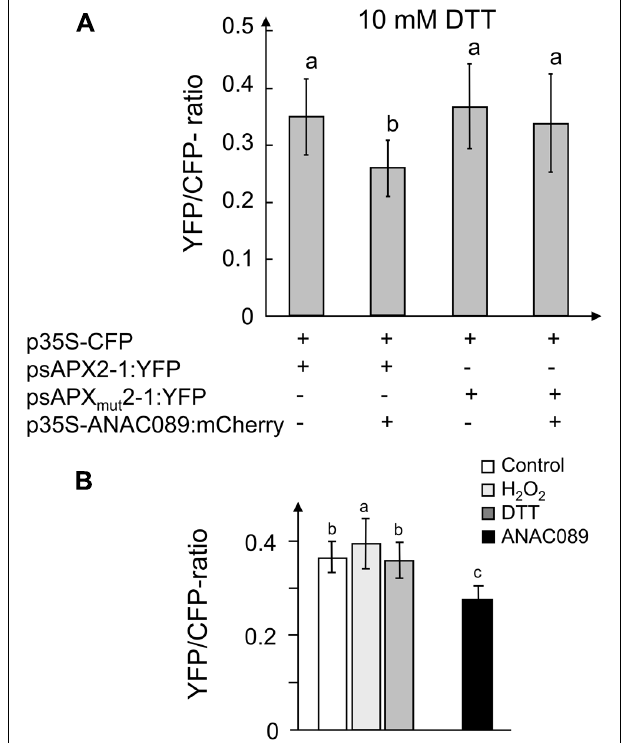
FIGURE 7 | Effect of overexpressedANAC089 on reporter gene expression and confirmation of involved cis -element CACG. (A) (1st bar) Co-transformation of fragment p sapx2 -1:YFP with 35S-CFP. (2nd bar) Co-transformation of p sapx2 -1:YFP with 35S-ANAC089-mCherry and 35S-CFP. (3rd bar) Co-transformation of p sapx2 -1mut:YFP with 35S-CFP. (4th bar) Co-transformation of p sapx2 -1mut with 35S-ANAC089-mCherry